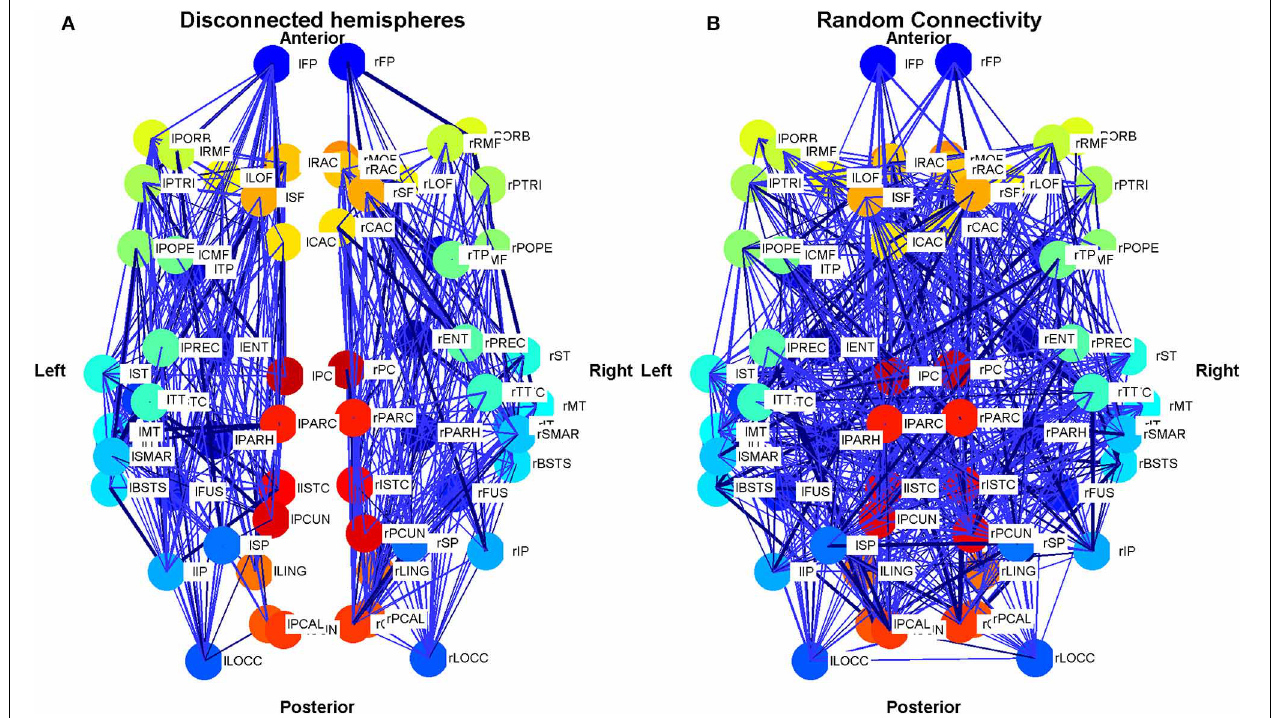
FIGURE 4 | Schematic plot (top view) showing the connections and connection weights between oscillators belonging to two modifications to the connectivity of the Cabral human brain model. (A) The left and right hemispheresofthebrainhavebeendisconnected,butconnectionswithineach hemisphere are left unchanged. (B) The connections and weights of each node are assigned randomly, but the degree distribution and weight distribution at